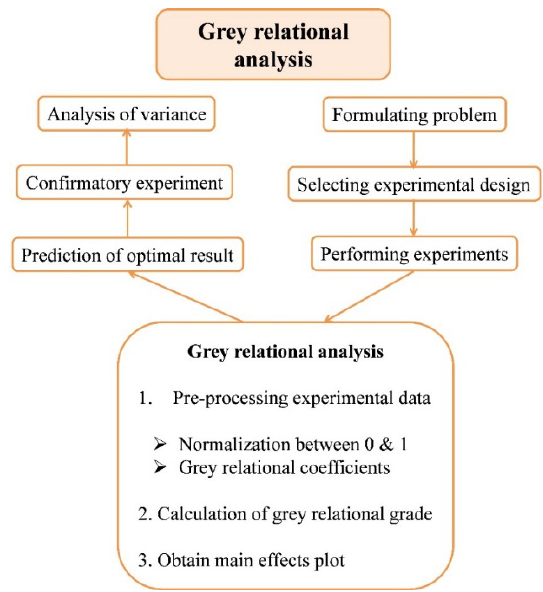
Figure 3. Schematics steps of Grey relational analysis 3.